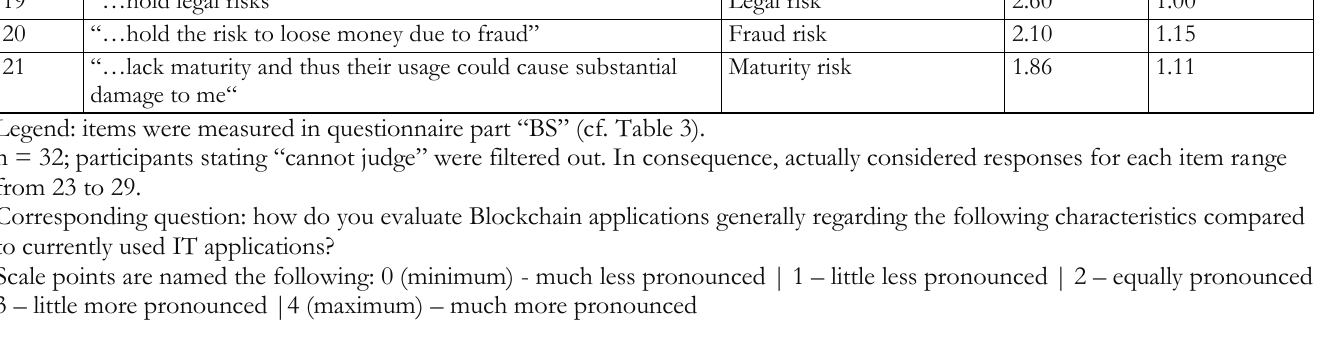
Table 8. Accuracy of the Structural Equation Model.